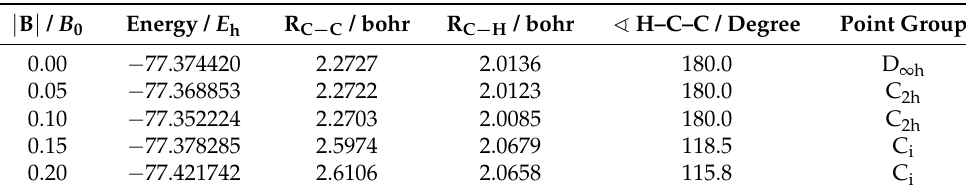
Table 3. Equilibrium geometries of C 2 H 2 at the magnetic field strengths considered in this work, optimized with the cTPSS functional and in the u-aug-cc-pVTZ basis. In all cases, the magnetic field is aligned perpendicular to the C–C bond.